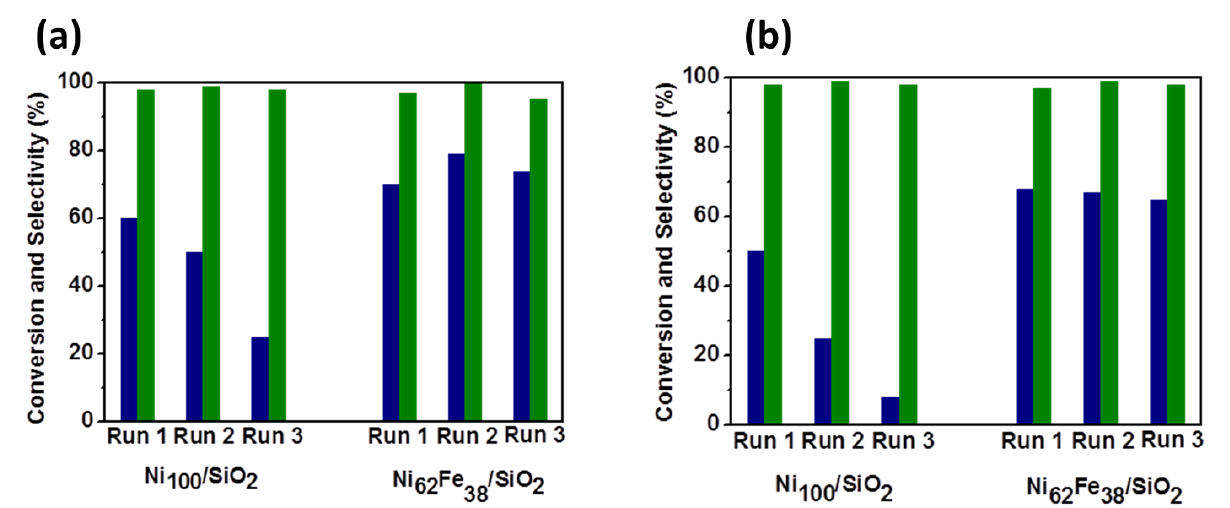
Figure 7. Catalyst recyclability study: ( a ) blue bars represent xylose conversion; green bars represent xylitol selectivity. Reaction conditions: Xylose — 0.26 mol L −1 ; 20 bar H 2 ; 80 °C; 108 mg catalyst; 90 min reaction time; n xylose /n Ni = 9.7; n xylose /n Ni + n Fe = 10.6. ( b ) Blue bars represent maltose conversion; green bars represent maltitol selectivity. Reaction conditions: 8.8 wt.% maltose; 20 bar H 2 ; 80 °C; 108 mg catalyst; reaction time = 8 h; n maltose /n Ni = 9.8; n maltose /n Ni + n Fe = 10.0. Adapted with permission from Refs. [49,50].